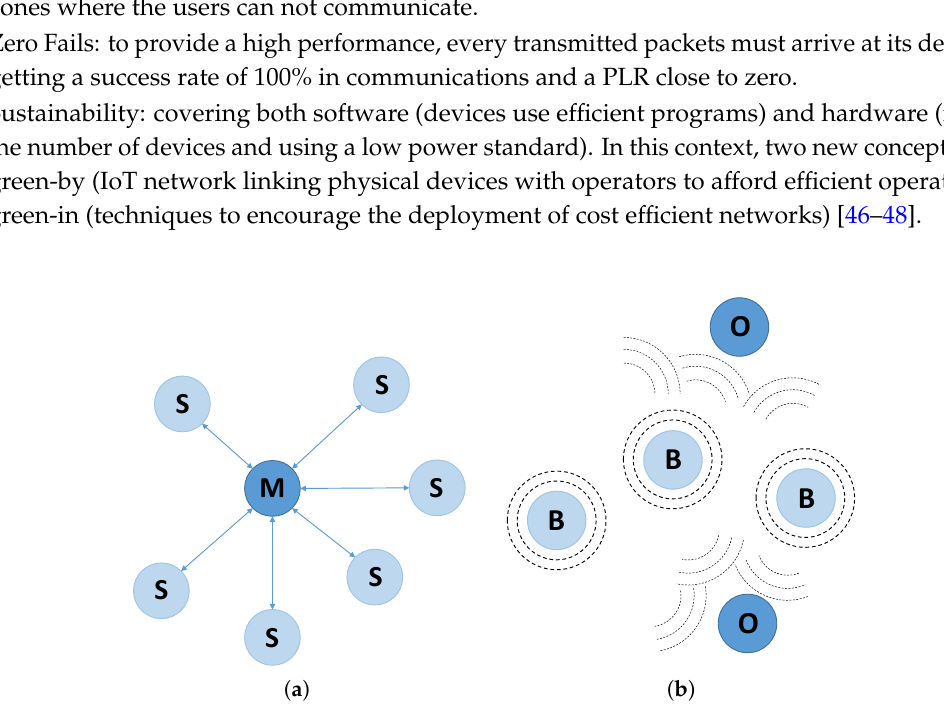
Figure 6. Available topologies in BLE standard (version 4.0). ( a ) Connection topology: (M) Master; (S) Slave; ( b ) Broadcast topology: (B) Broadcaster; (O)